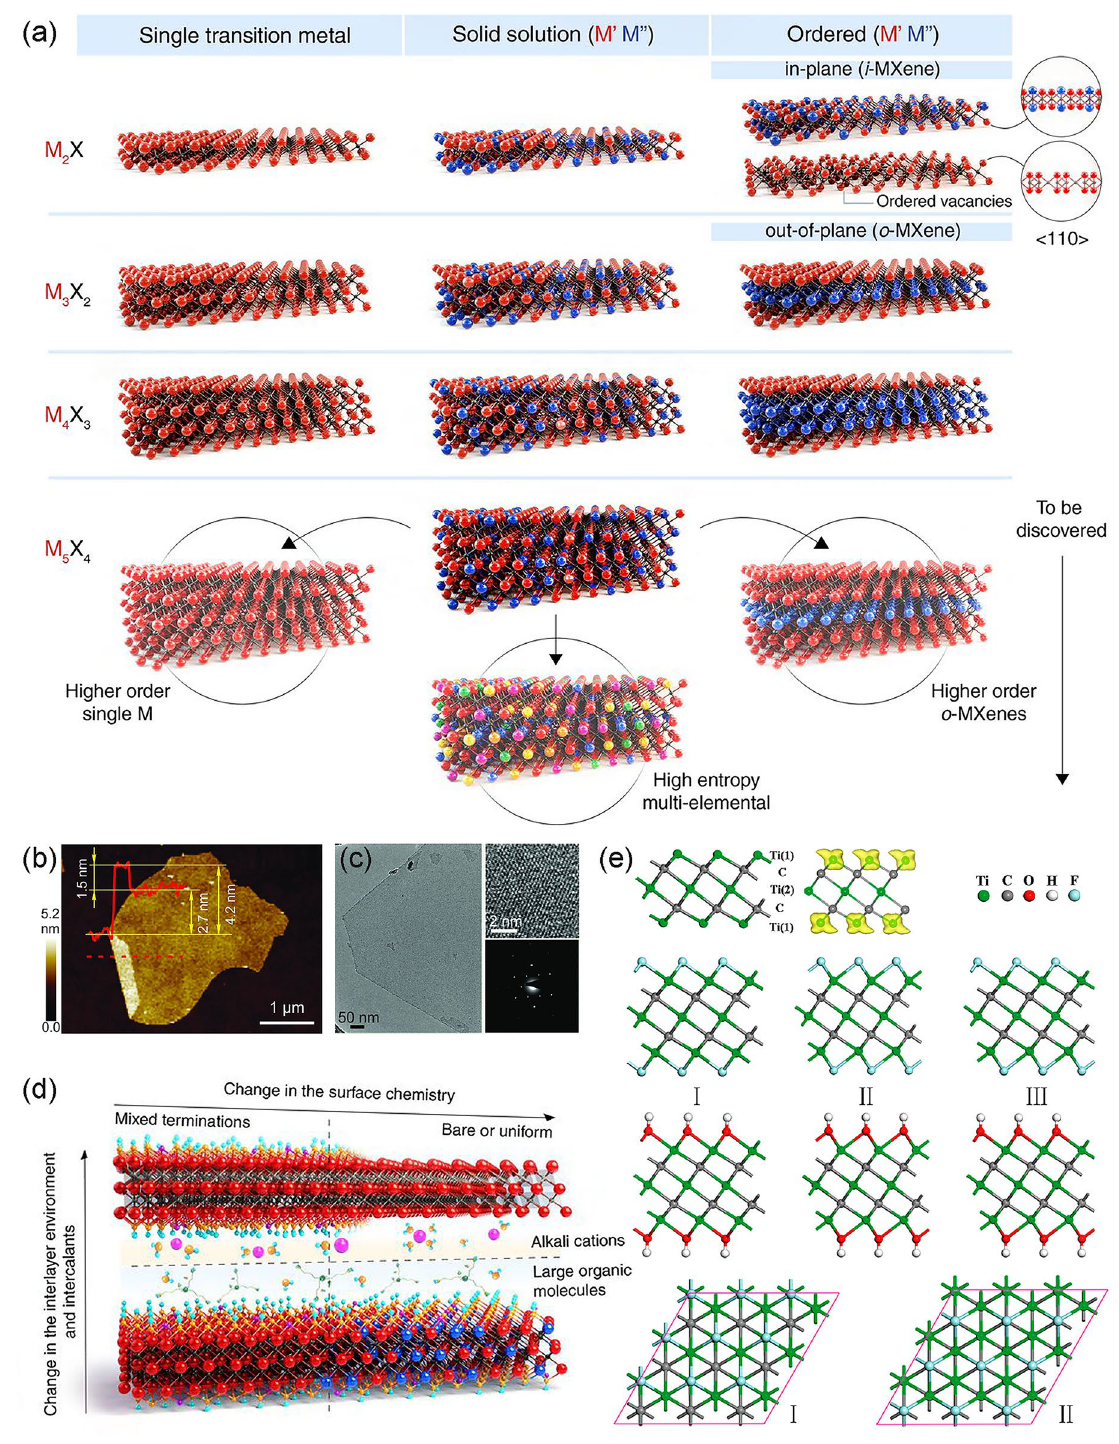
Fig. 4 a Schematic illustration of the MXenes with a general formula of M n+1 X n T x [35]. Copyright 2021, The American Association for the Advancement of Science. b The AFM image of a folded Ti 3 C 2 T x flake on Si/SiO 2 ; c The HRTEM image and SAED image of Ti 3 C 2 T x